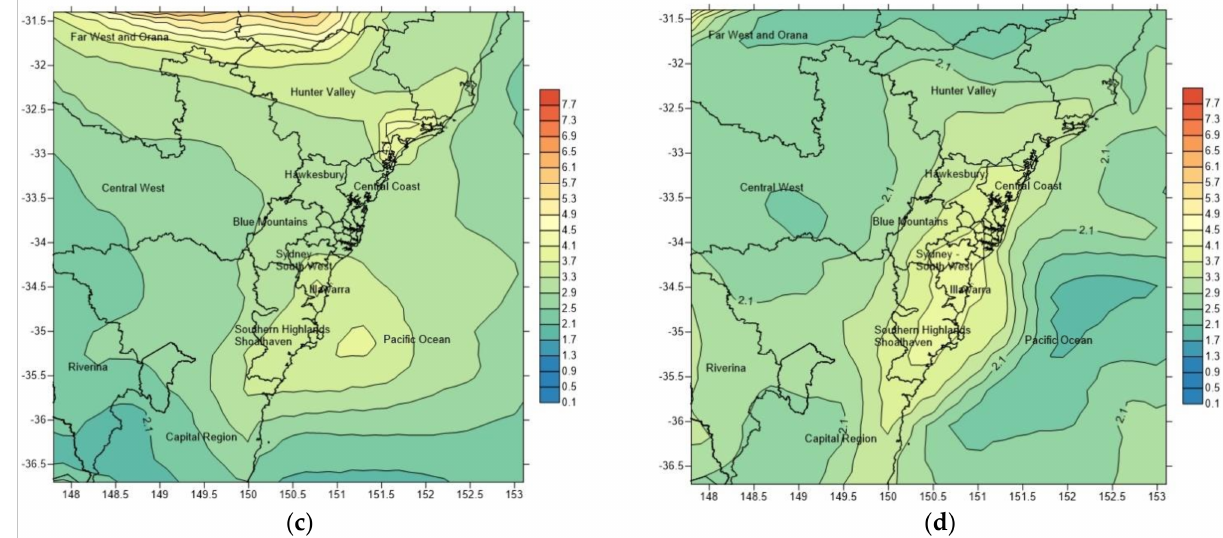
Figure 9. Daily average PM 2.5 predicted concentration due to dust storm in Sydney and neighbouring Local Government Areas (LGAs) on 12 ( a ), 13 ( b ), 14 ( c ) and 15 February 2019 ( d ).